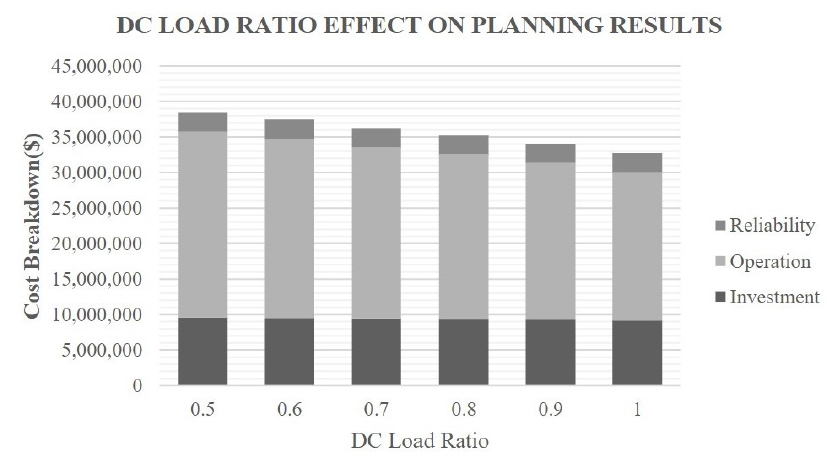
Figure 5. DC load ratio effect on planning results.